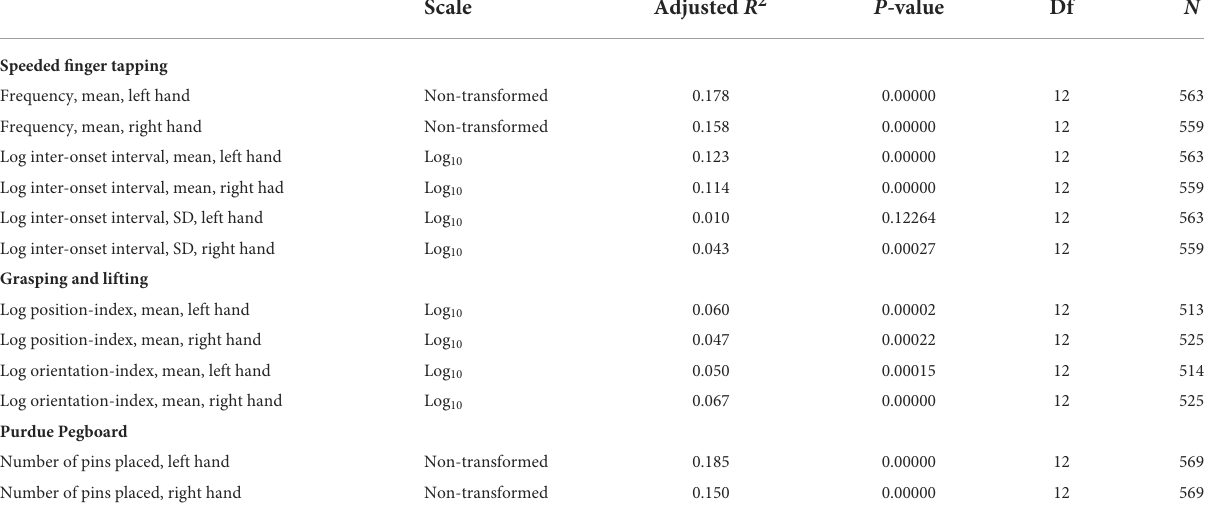
TABLE 6 Model 1 quality